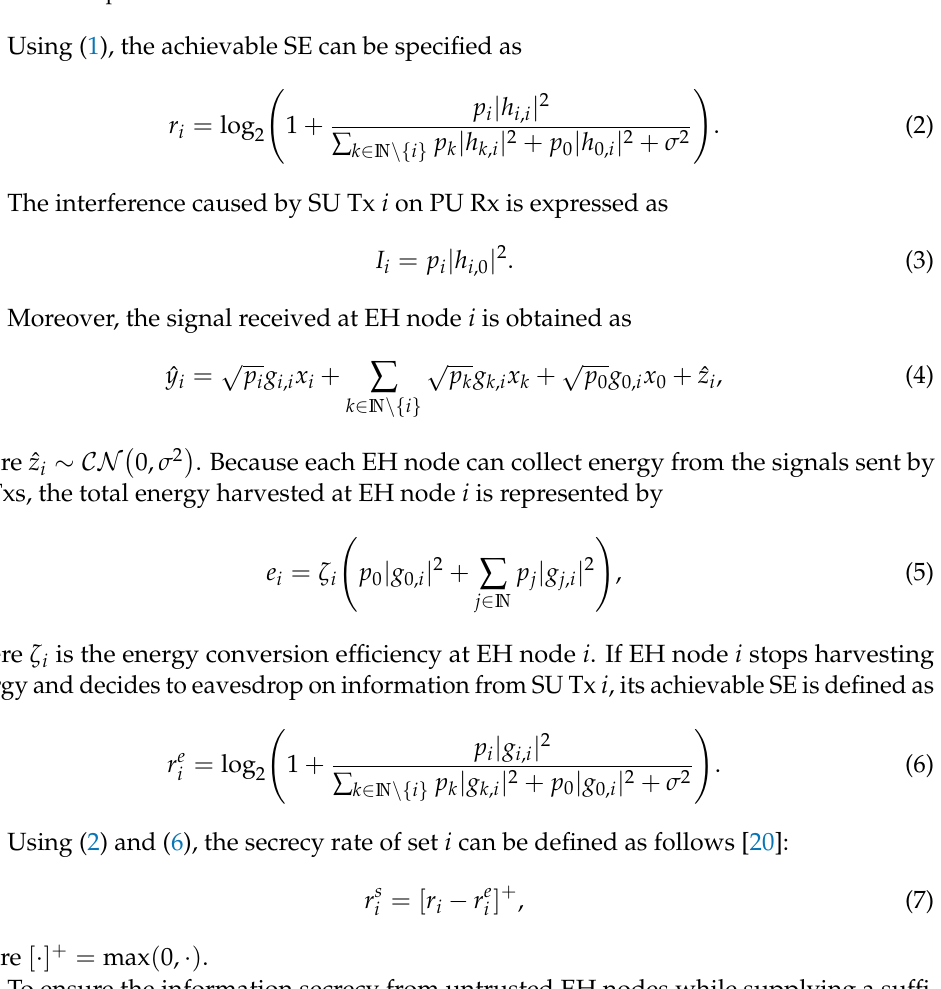
Figure 1. Example of WPCRNs for secure communications with N =